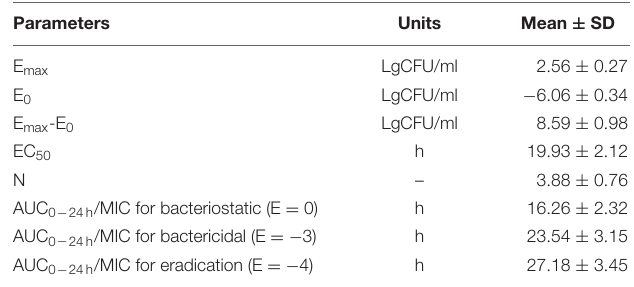
TABLE 3 | The main parameters of PK/PD modeling of MBF ex vivo after a oral dose 2 mg/kg in pigs.